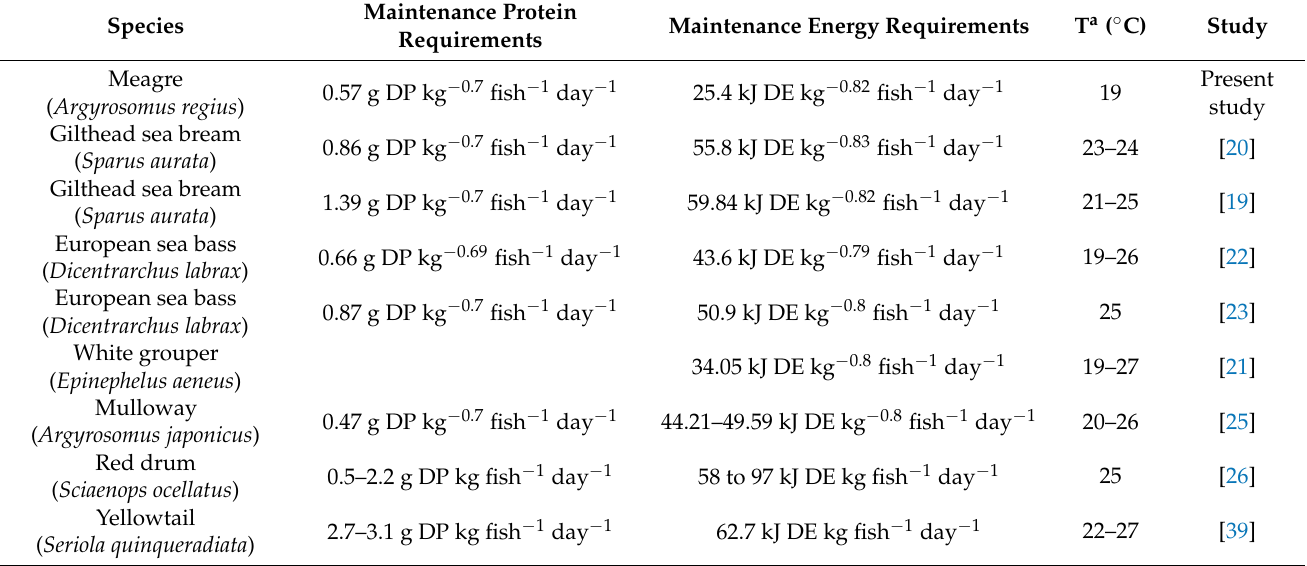
Table 5. Maintenance protein and energy requirements estimated for several fish